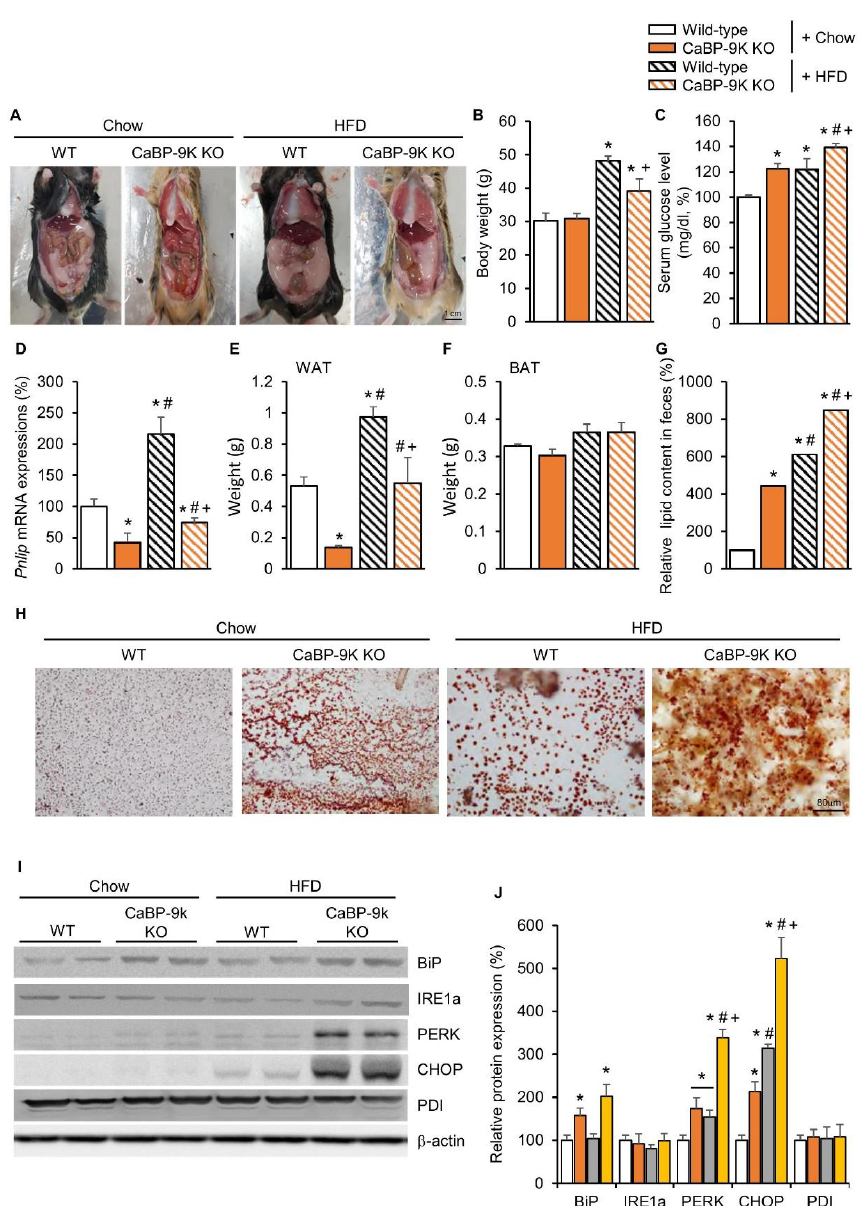
Figure 4. The e ff ects of CaBP-9k ablation in high-fat diet (HFD)-induced diabetes mellitus model. Lipid deposition for each group ( A ); body weight ( B ), serum glucose level at resting state ( C ), pancreatic lipase expression ( D ), WAT ( E ) and BAT ( F ) mass, and fecal lipid content ( G ); and fecal sudan III staining ( H ). ER stress marker protein expression in pancreas ( I , J ). Values are expressed means ± SDs * p < 0.05 versus WT chow diet; # p < 0.05 versus CaBP-9k KO chow diet; + p < 0.05 versus WT HFD. Scale bar = 1